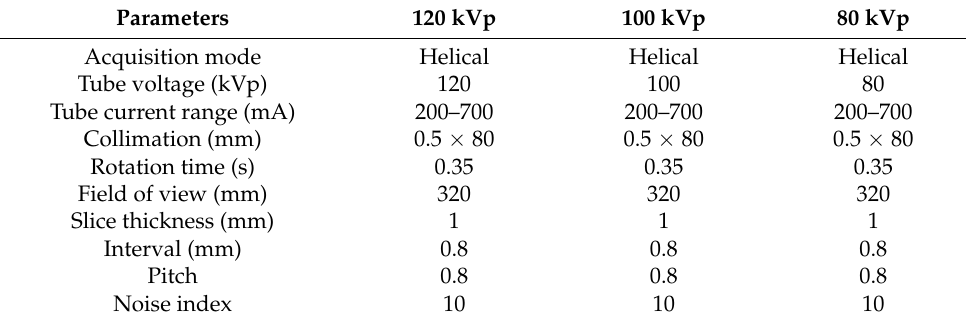
Table 1. CT acquisition parameters in each peak kilovoltage (kVp)